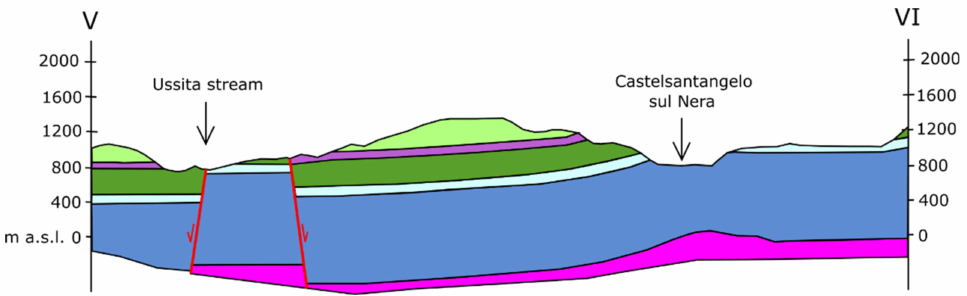
Figure 10. Hydrogeological cross-section (SSE-NNW oriented) modified from [49]. The colors in section refers to the sketch of hydrogeological complexes reported in Figure 1.